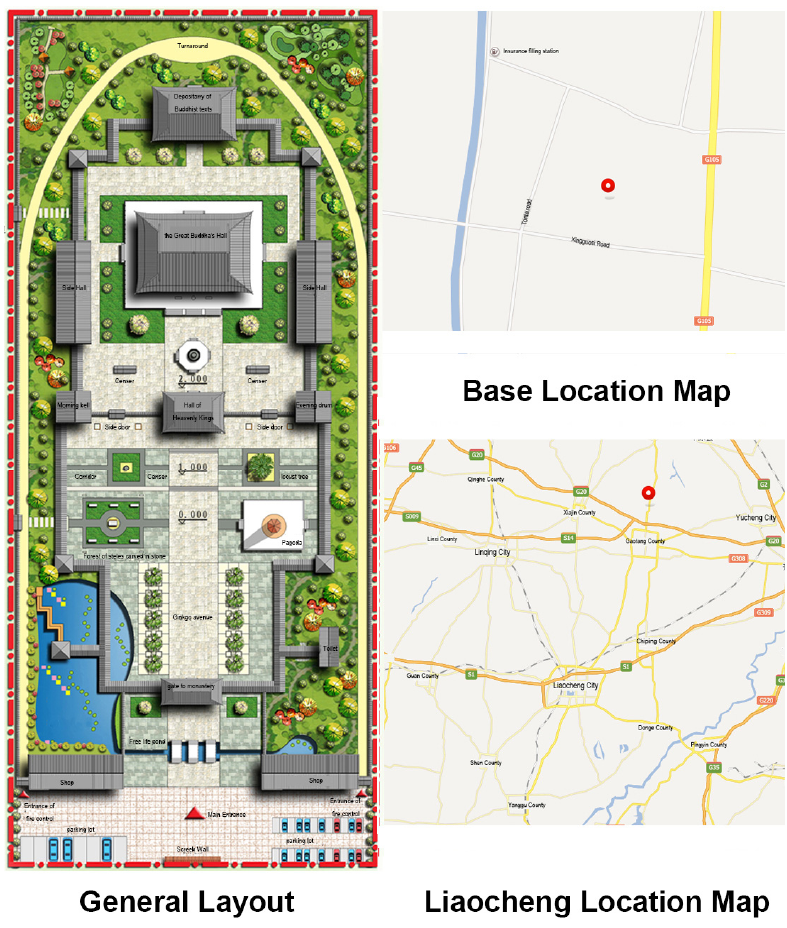
Figure 1. Planning and transformation.